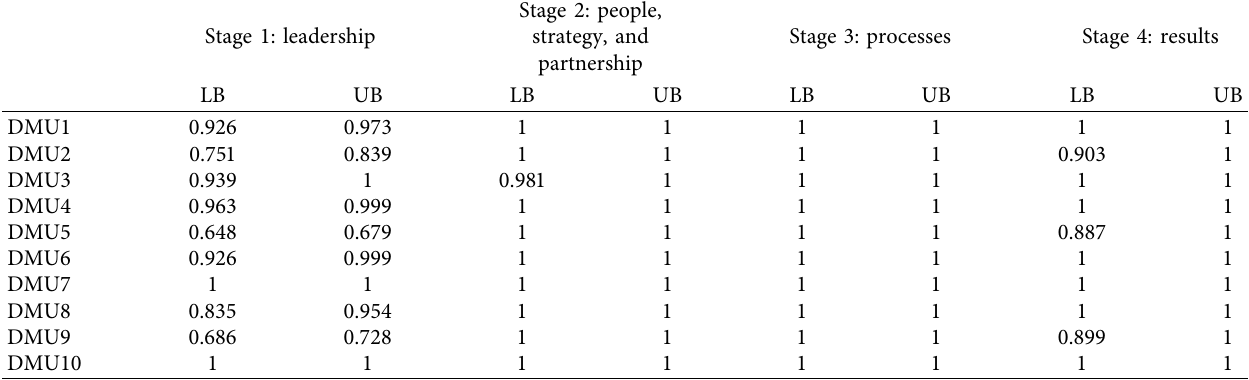
Table 5: The efficiency of EFQM stages at α � 0.25.